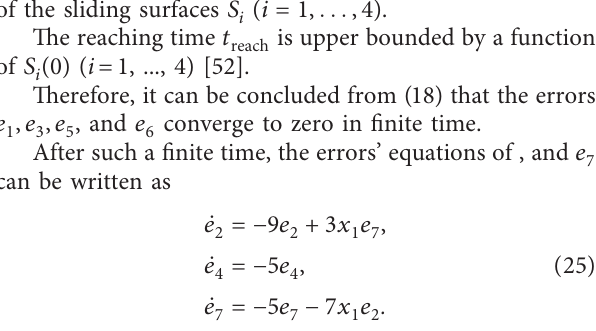
8(a) depicts the L norm of the error ������������ 􏽱 2 ‖ x − y ‖ 2 ( t ) and ‖ e ‖ � 􏽐 7 versus time. Also, the states x i i i � 1 1 y ( t ) versus time and x ( t ) and y ( t ) versus time are plotted 1 7 7 in Figures 8(b) and 8(c), respectively. Figure 8(d) plots the ( t ) and y ( t ) versus x ( t ) and y ( t ) ; the figure state x 7 7 1 1 shows the efficacy of the static sliding mode controller to drive the dynamics from one attractor to a